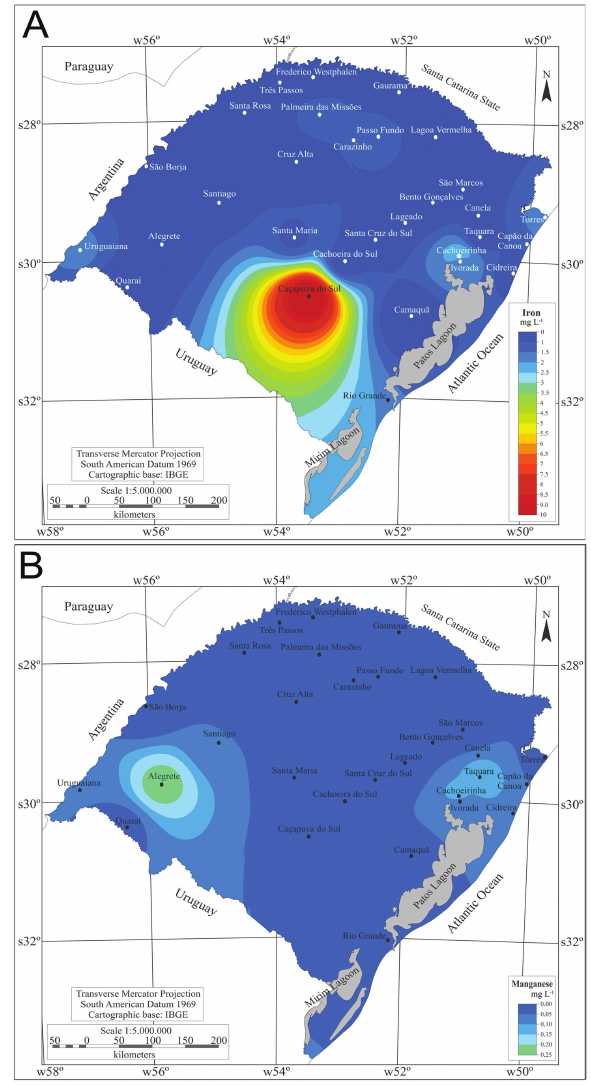
Fig. 5. Mean waterborne (A) iron and (B) manganese in various cities of Rio Grande do Sul in the period of 1996 to 2011 (Source CORSAN/RS). Table 1. Minimum and maximum pH values in which there is 100% survival in the juveniles of certain species of teleost fish raised in southern Brazil. nd: not determined (adapted from Parra & Baldisserotto,